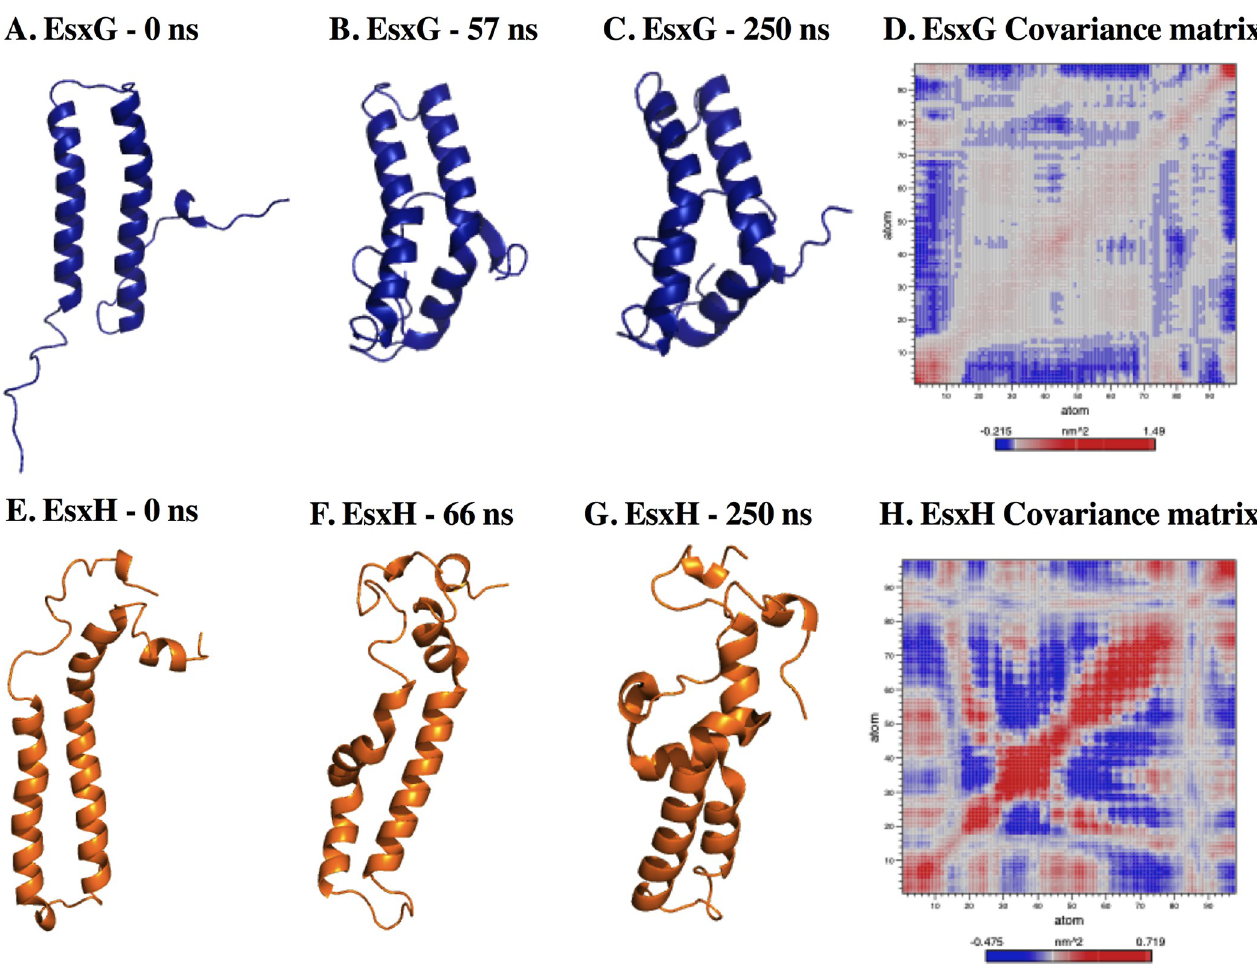
Fig 4. Global structure behavior of EsxG at 310 K. (A). at 0 ns of simulation. (B). at 57 ns of simulation. (C). at 250 ns of simulation. (D). First principal component covariance matrix. The matrix is color-coded, from red (correlated displacements) to blue (non-correlated displacements). The diagonal line stands for the correlation between the residues paired with themselves, while the color stands for the correlation between each residue pair during the 250 ns simulation. Global structure of the first cluster from EsxH at 310 K. (E). 0 ns of simulation. (F). 66 ns of simulation. (G). 250 ns of simulation. (H). First principal component covariance